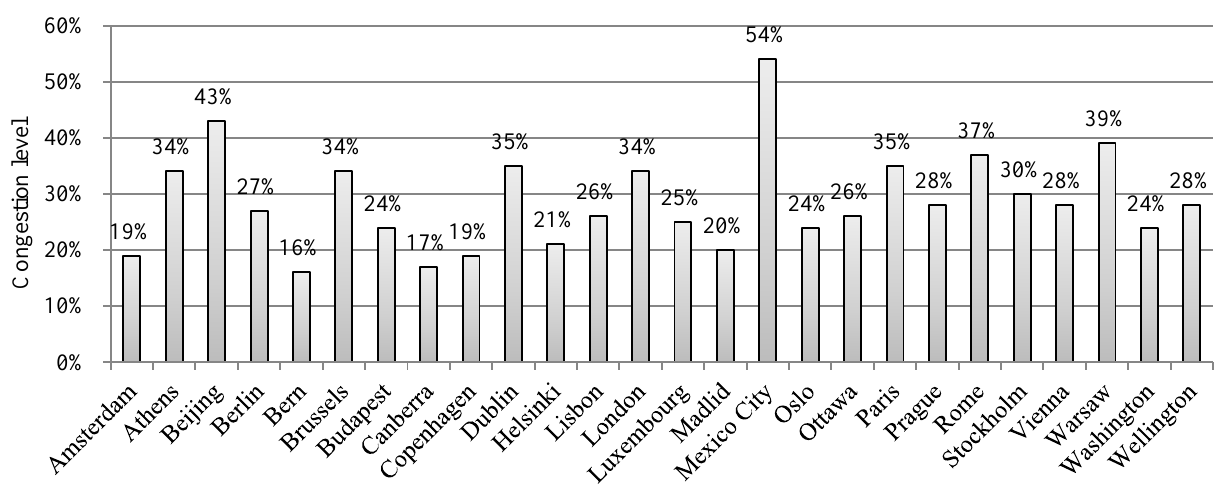
Figure 1. Congestion levels in capital cities in 2013 (data source: [12]). All founding members of OECD are included, excepting Iceland and Turkey, because of lack of